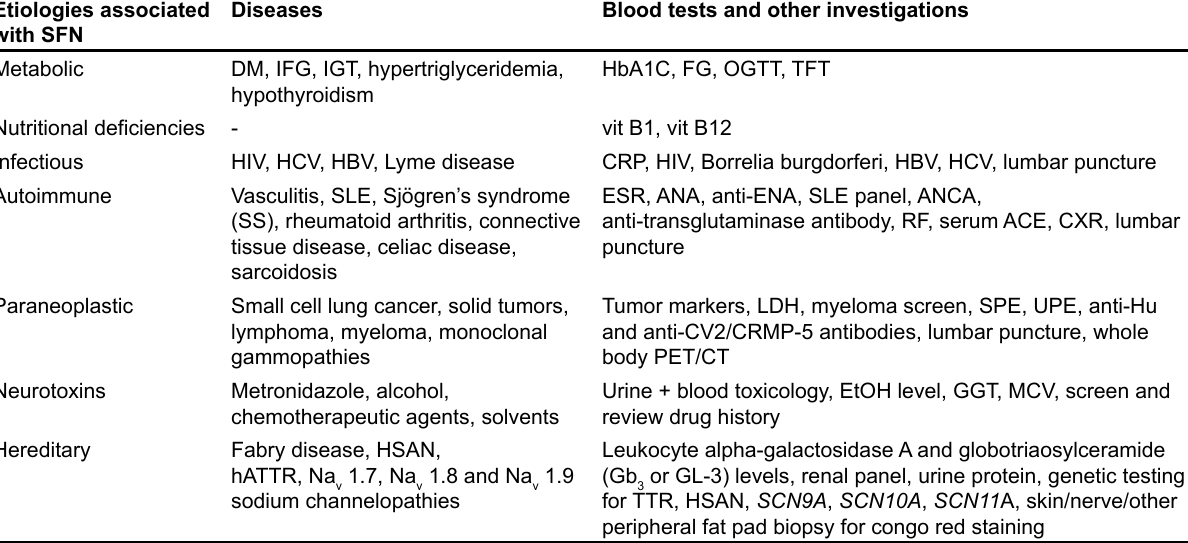
Table 2. Blood tests according to clinical suspicion of underlying SFN etiologies Etiologies